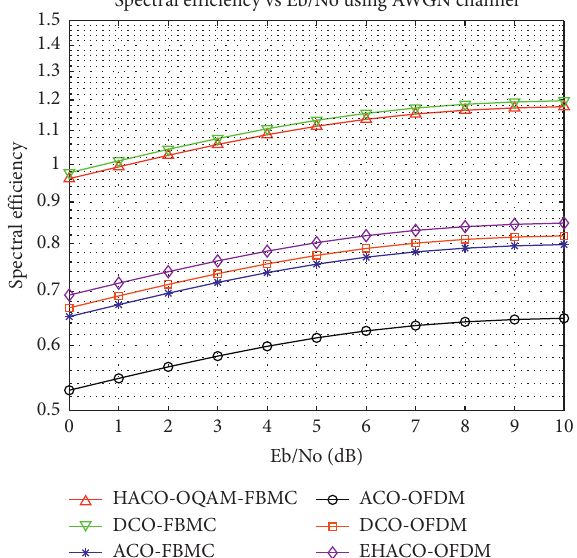
Figure 9: Simulation of computational complexity (multiplica- tions) of ACO-OFDM, ACO-FBMC, DCO-OFDM, ADO-OFDM, DCO-OFDM, and HACO-OQAM-FBMC.